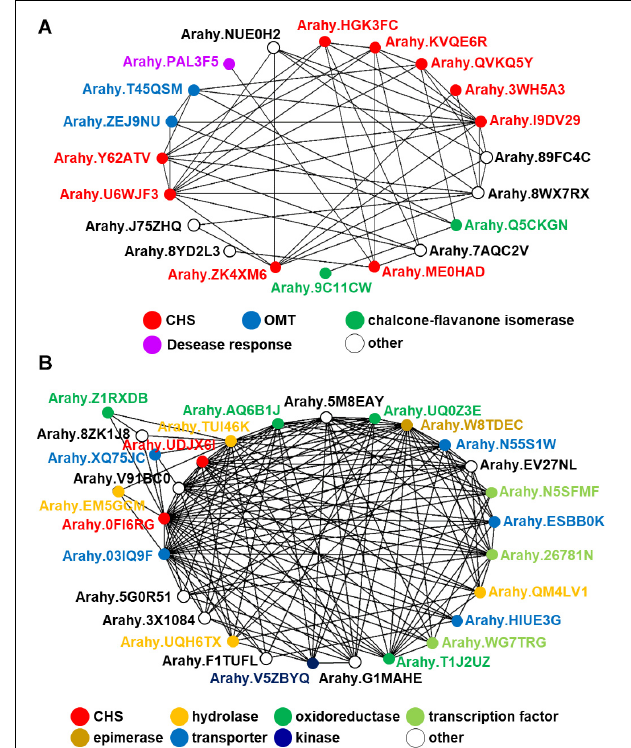
FIGURE 6 | In silico co-expression gene network analysis of the peanut STS gene putatively annotated by comparative genomics. (A) AhSTS , (B) Arahy.0FI6RG